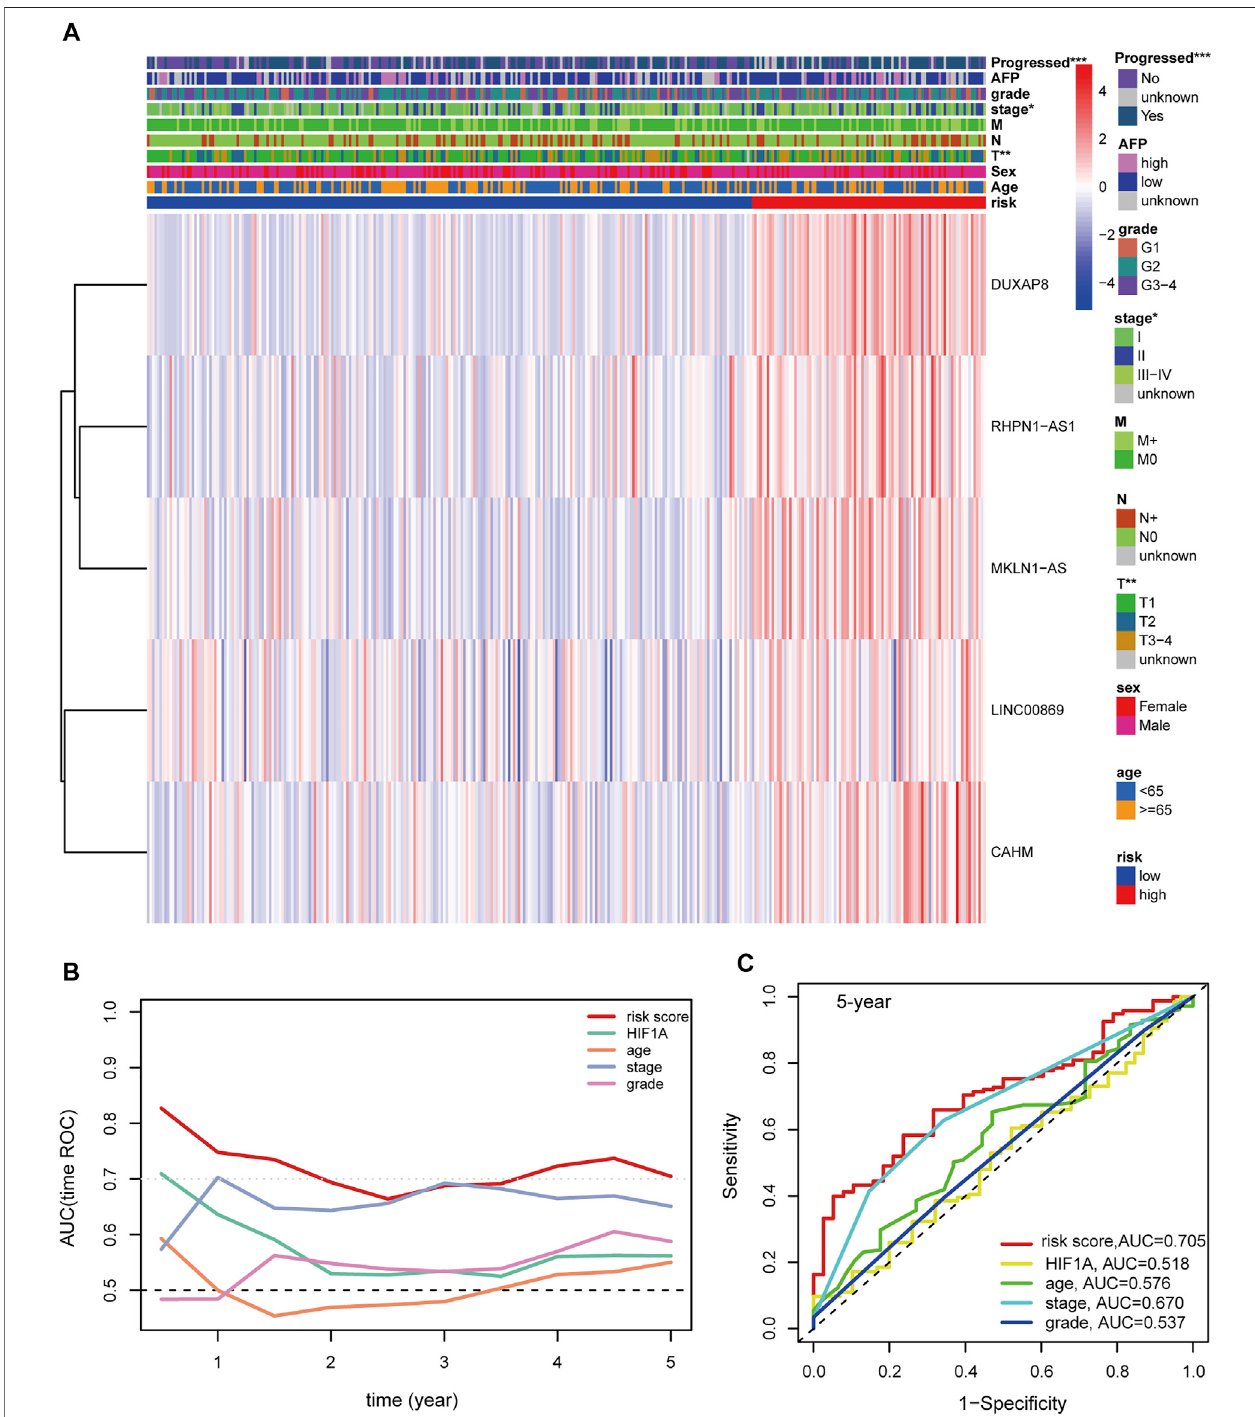
FIGURE 7 | (A) Distribution landscape of the hypoxia-related risk groups among clinical parameters and the heatmap of the expression levels of the fi ve key lncRNAs in HCC patients in the TCGA-LIHC cohort. The color blue denotes a low expression level and red represents a high expression level. (B) AUCs of the time- dependent ROC curves for risk score, HIF1A mRNA expression, age, stage, and tumor grade in HCC patients. (C) AUCs for the 5-years prognostic prediction of risk score, HIF1A mRNA expression, age, stage, and tumor grade in HCC patients. AUC: area under the curve. ROC: receiver operating characteristic curve. HCC: hepatocellular carcinoma. ***, p < 0.001; **, p < 0.01; *, p < 0.05.